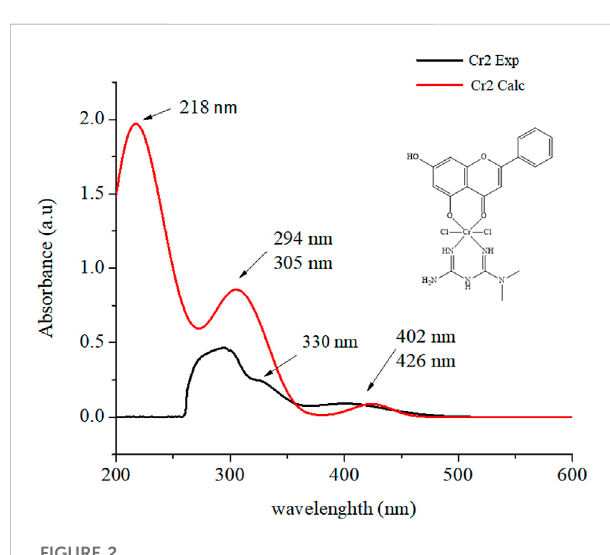
FIGURE 2 Experimental- (black) and TD-DFT-calculated (red) UV-Vis absorption spectrum of Cr2